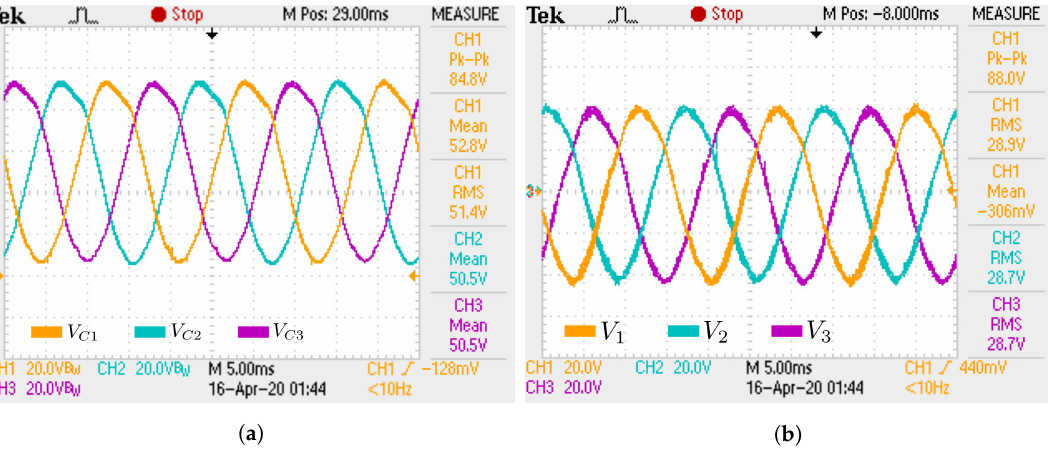
Figure 27. Experimental waveforms of capacitor and load phase voltages for RL load case: ( a ) Capacitor voltages; ( b ) Load phase